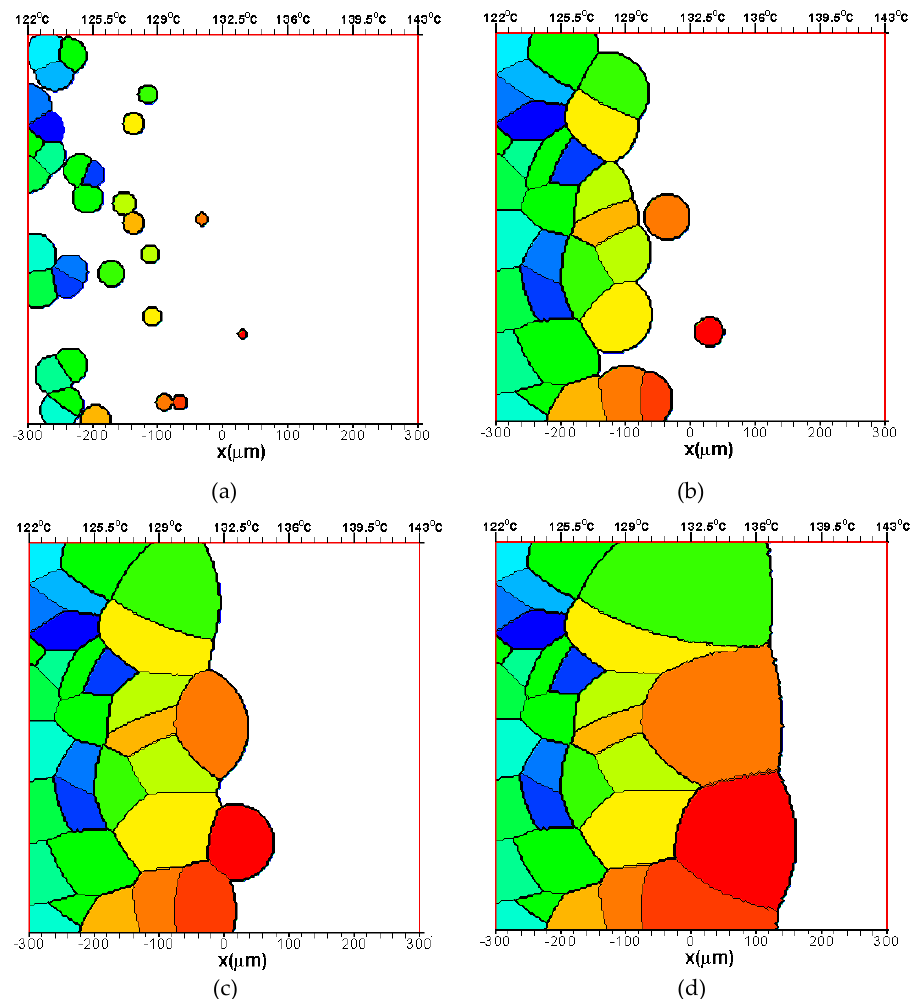
Figure 6. Spherulite shapes predicted by morphological Monte Carlo method: ( a ) t = 2 min, ( b ) t = 6 min, ( c ) t = 15 min, ( d ) t = 60